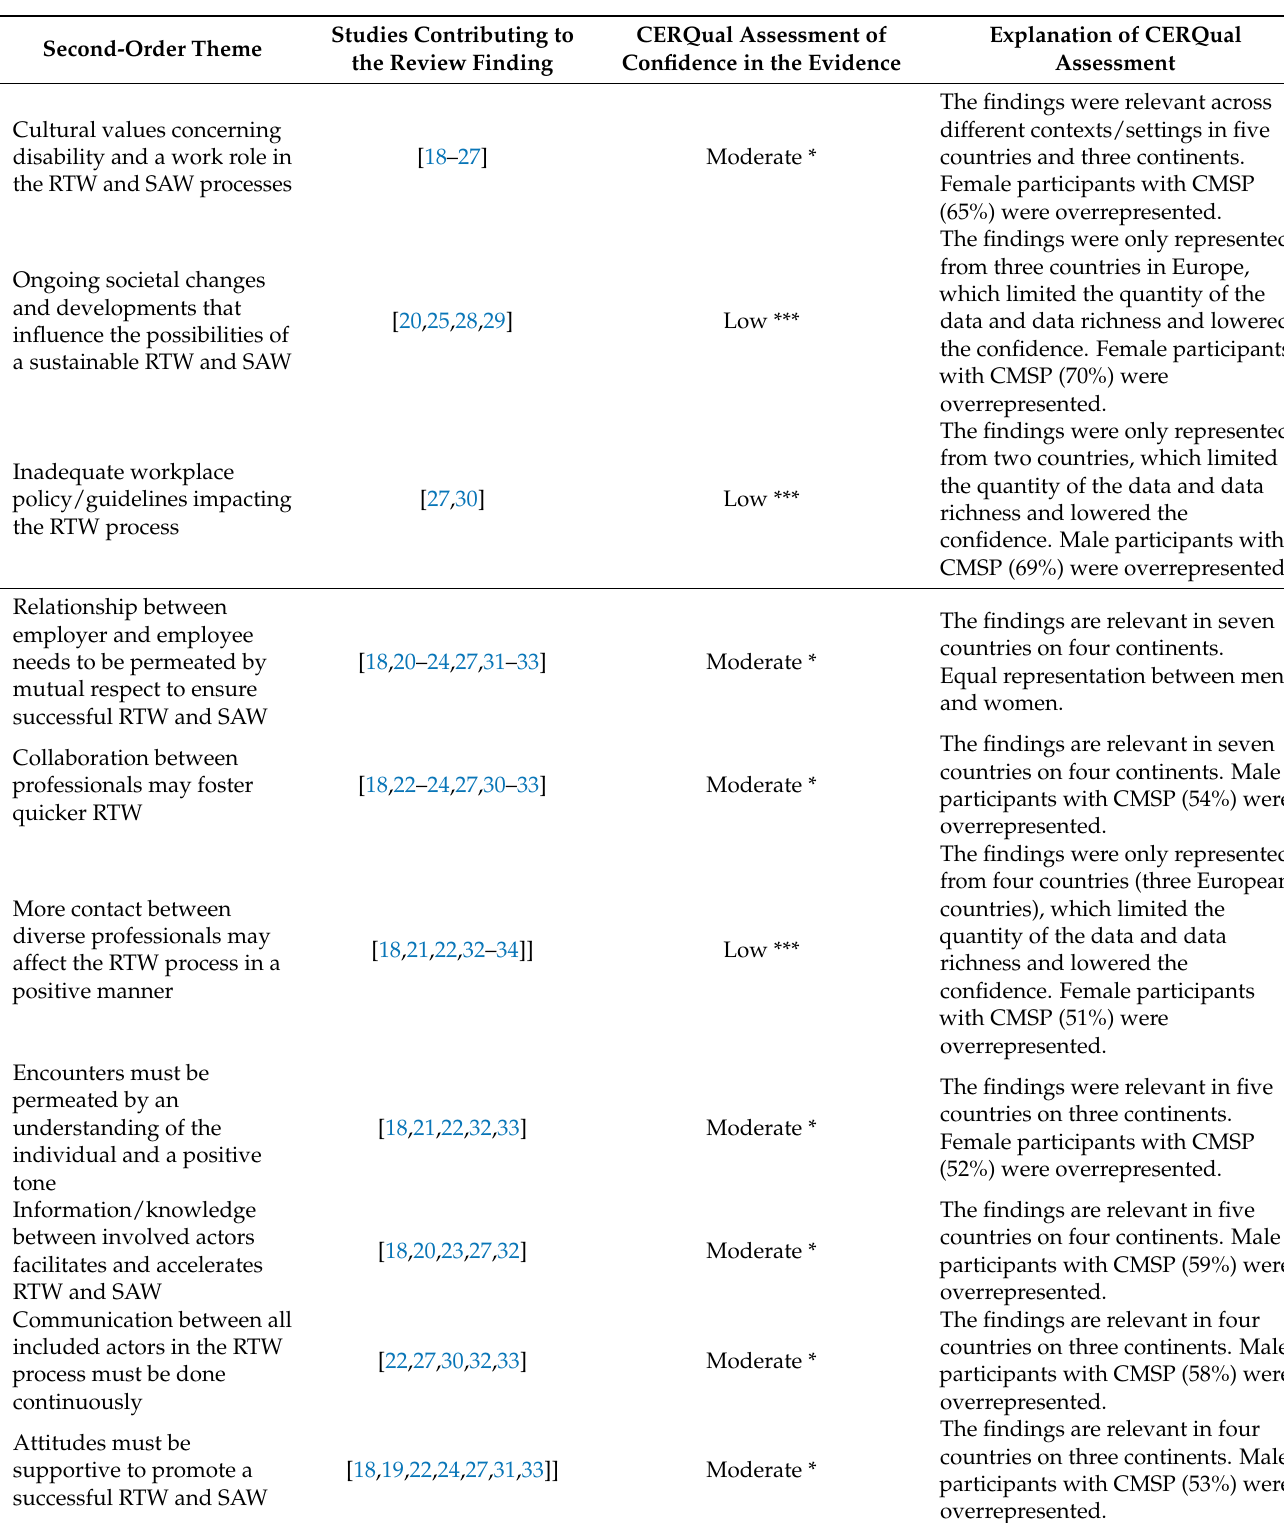
Table 4. Critical appraisal of review finding using Confidence in Evidence from Reviews of Qualitative research (CERQual) evaluation. The second-order themes were developed to explain the